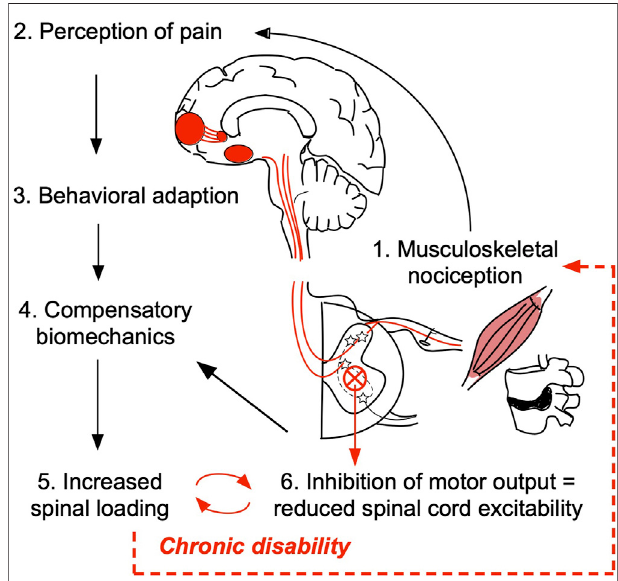
FIGURE 4 | Working hypothesis of the relationship between pain/ nociception and patient compensatory STS movement biomechanics. Damage in the peripheral tissue, such as muscle, ligament, or intervertebral disc may trigger the low back pain (LBP) onset (1). Upon initial injury, activation of primary nociceptive afferents triggers a cascade of action potentials across the central neural axis ultimately propagating the signal to thehigher brainstructures responsibleforcognitive andemotionalprocessing ofpain (2).Accordingtopain fear-avoidance modelpatientsmayconsciously/ volitionally seek to reduce physical activity and/or adopt compensatory strategiestoavoidmovingapainfuljoint(3and4).Inthisstudy,wedetermined that patients use a leaning forward – swing back sit-to-stand strategy that results in higher spinal loading (5). Presumably, the inef fi cient strategy/ increased spinal loading maintains ongoing nociceptive tone. Persistent nociceptivesignalingovertimeresultsindecreasedmotoroutputandreduced spinal cord excitability (6) which at the subconscious level may contribute to the observed compensatory biomechanics, locking individuals with LBP in a viscous cycle of chronic